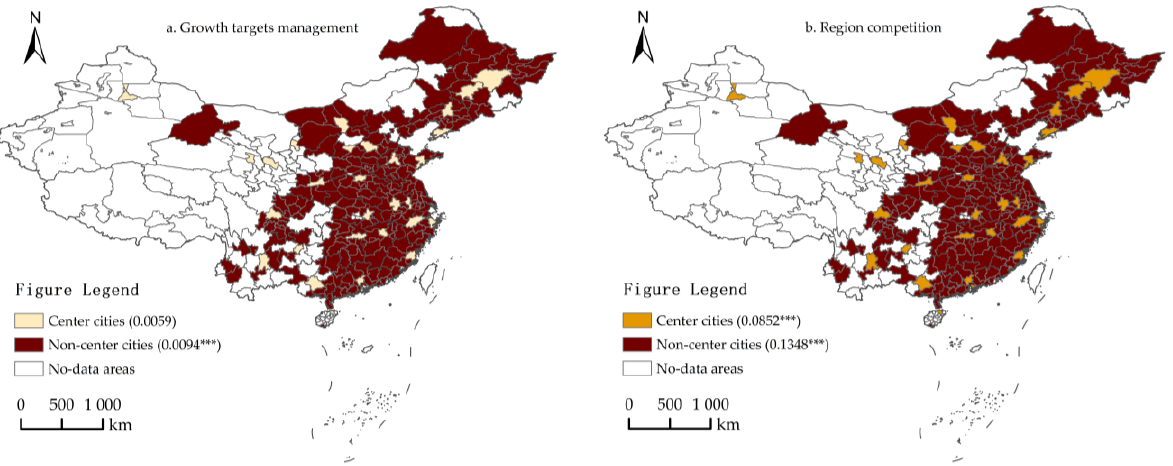
Figure 5. Heterogeneity analysis results (Administrative levels). ( a ) The impact of growth targets management (gt) on the ULUGE; ( b ) the impact of regional competition (w·gt) on the ULUGE. *** denotes significance at the 0.01 level. As above, the shade of the color represents the relative strength of the effect. strength of the Table 11. Heterogeneity analysis results (Administrative levels).